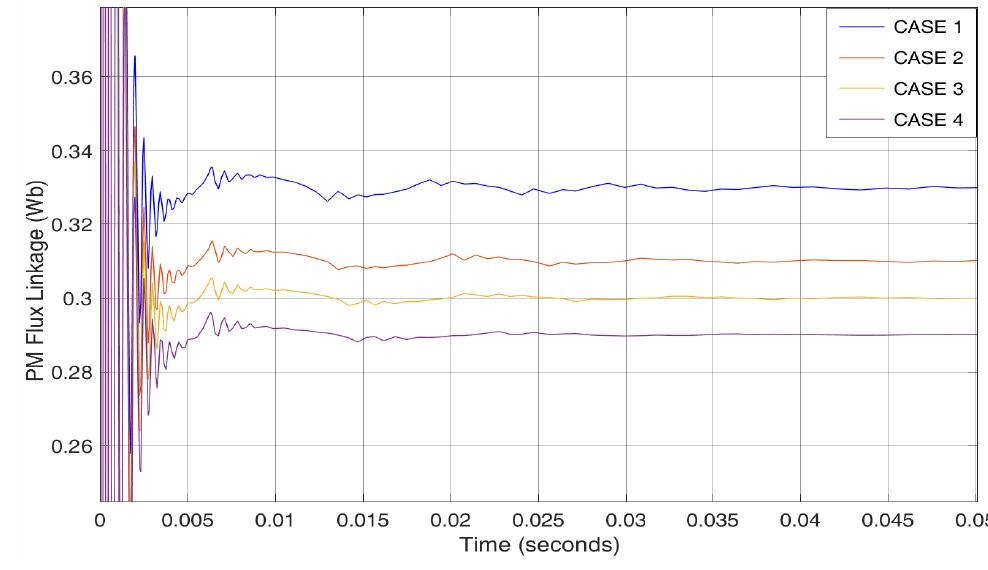
Figure 10. Estimates PM flux linkage in Wb against the reference at different temperatures. Figure 11 represents the i q , corresponding to the PM flux linkage with a change of temperature from 20 ◦ C to 65 ◦ C. The settling time can be noted to be 0.1 s. Moreover, it can also be seen that, with an increase of temperature, stator current i q also increases and PM flux linkage decreases. The stator current q-axis error at nominal temperature 20 ◦ C is also presented in Figure 12. The transient of error is between 0.24 to − 0.16 approximately. The setting time 0.14 s can be observed.